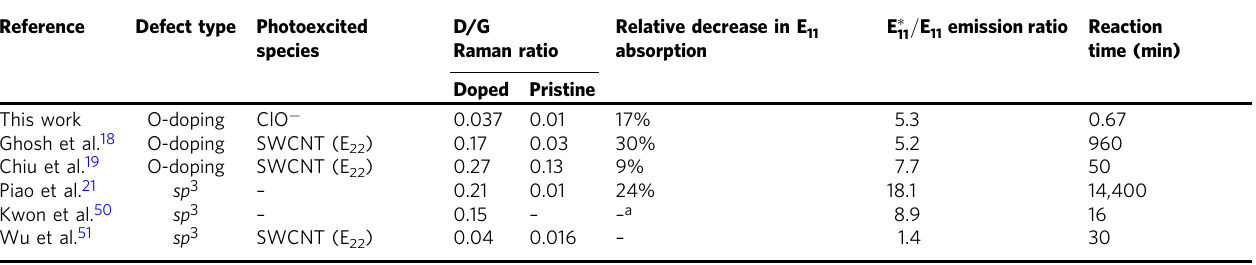
Table 1 Comparison of aqueous reactions generating SWCNT fl uorescent quantum defects